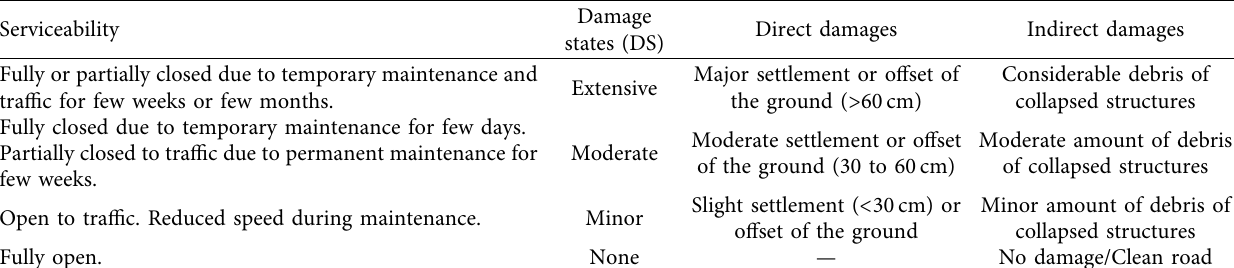
Table 4: Damage States of Roadway and its Assets (Argyroudis and Kaynia